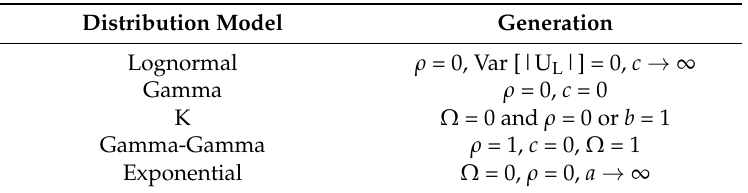
Table 1. Parameter set for the generation of widely used distribution models from the unifying M (alaga) distribution model, where U L represents the line-of-sight (LOS) component, Var[ · ] denotes the variance operator, and | · | stands for the absolute value